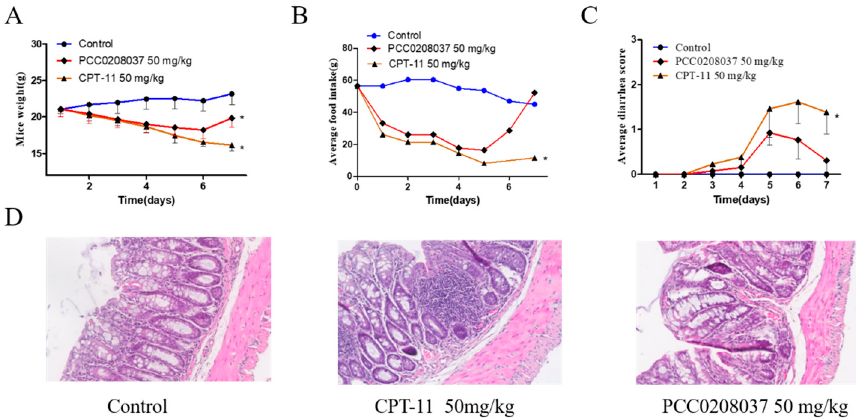
Figure 9. Preliminary toxicological evaluation of PCC0208037 and CPT-11 in mice. ( A ) Body weight loss induced by PCC0208037 and CPT-11. ( B ) Food intake reduction induced by PCC0208037 and CPT-11. ( C ) PCC0208037 and CPT-11 both induced diarrhea during the repeated treatment. ( D ) H&E staining to visualize paraformaldehyde-fixed sections of the colorectum. * p < 0.05 as compared to the control.